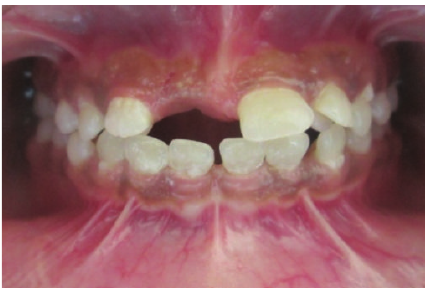
Figure 7: Intraoral photographs.